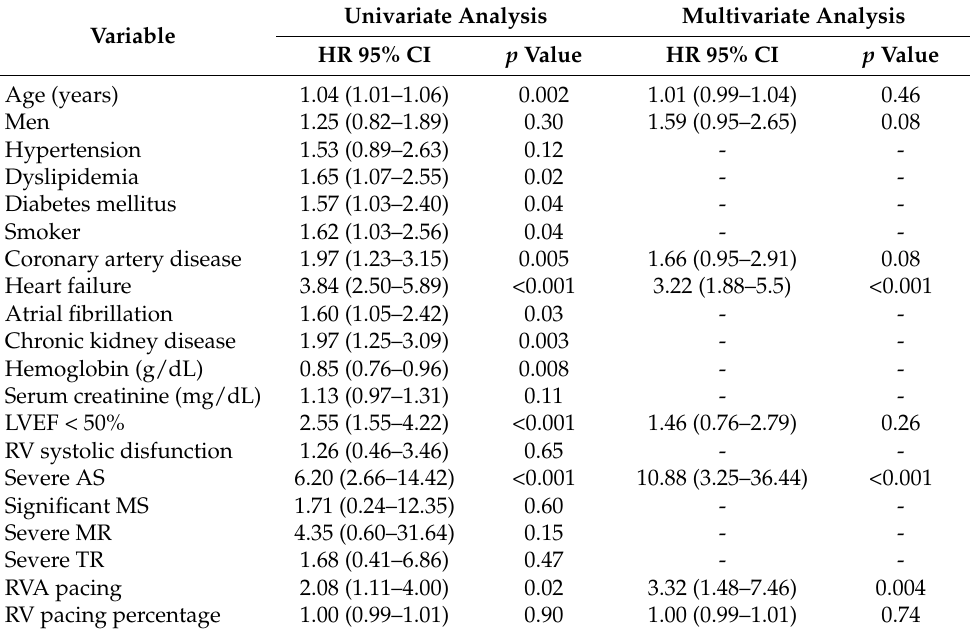
Figure 2. Heart failure during follow-up in patients with septal and apical right ventricular pacing lead. Table 3. Univariate and multivariate analysis of predictors of the primary